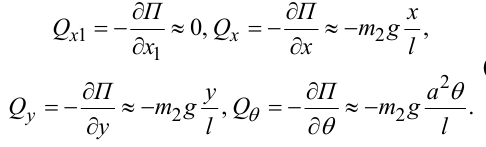
Figure 2. Computational scheme of bifilar